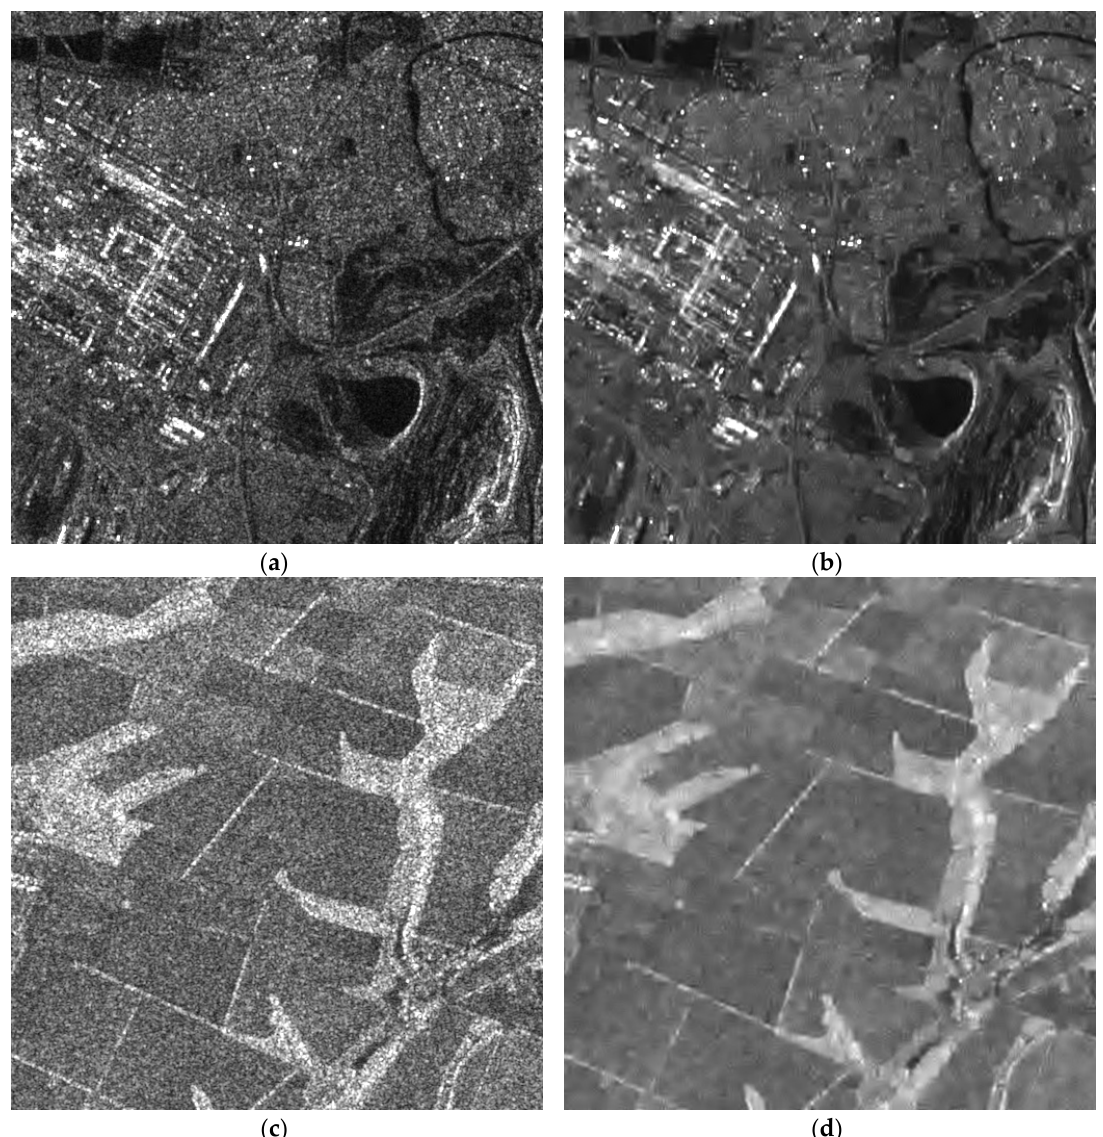
Figure 8. Noisy ( a , c ) and filtered ( b , d ) real images corresponding to obtained min ( a , b ) 5.35 dB and Figure 8. Noisy ( a, c ) and filtered ( b, d ) real images corresponding to obtained min ( a, b ) 5.35 dB and max ( c , d ) 13.89 dB predicted improvement of PSNR for real Sentinel-1 max ( c, d ) 13.89 dB predicted improvement of PSNR for real Sentinel-1 data.